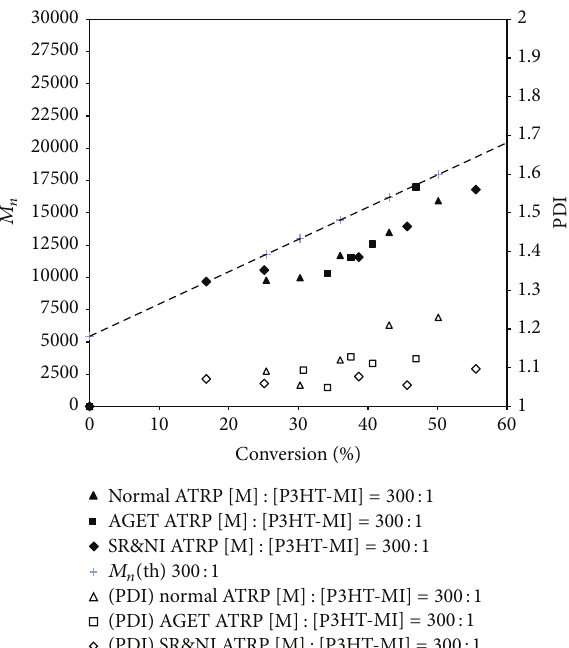
Figure 12: Dependence of molecular weight and polydispersity index on monomer conversion for the polymerisation of styrene and CMS via different ATRP systems, using the P3HT macroinitator (monomers/macroinitiator mole ratio =